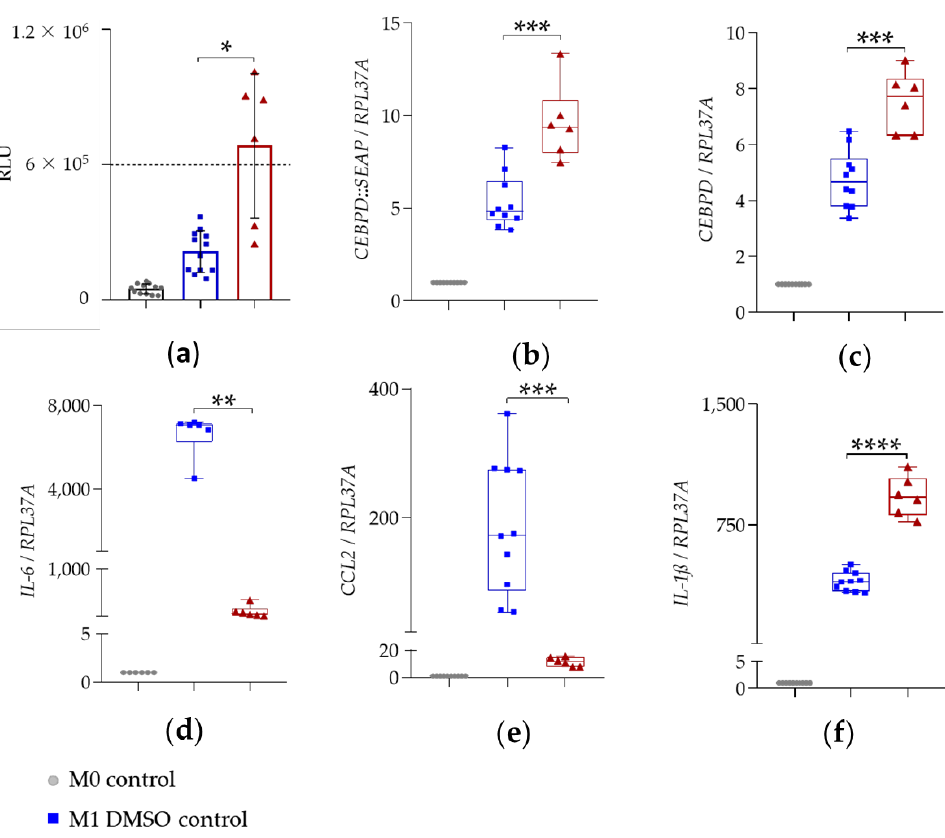
(Table 2). Ro 11-1464 caused approximately 9-fold suppression in the mRNA expression of IL-6 and CCL2 (Table 3). Whereas Ro 11-1464 showed no effect on IL-1ß mRNA expression (Figure 5f; red triangles), this was more than doubled (Table 2) by I-BET151, indicating a pro-inflammatory action at the same time point (Figure 4f; red triangles).